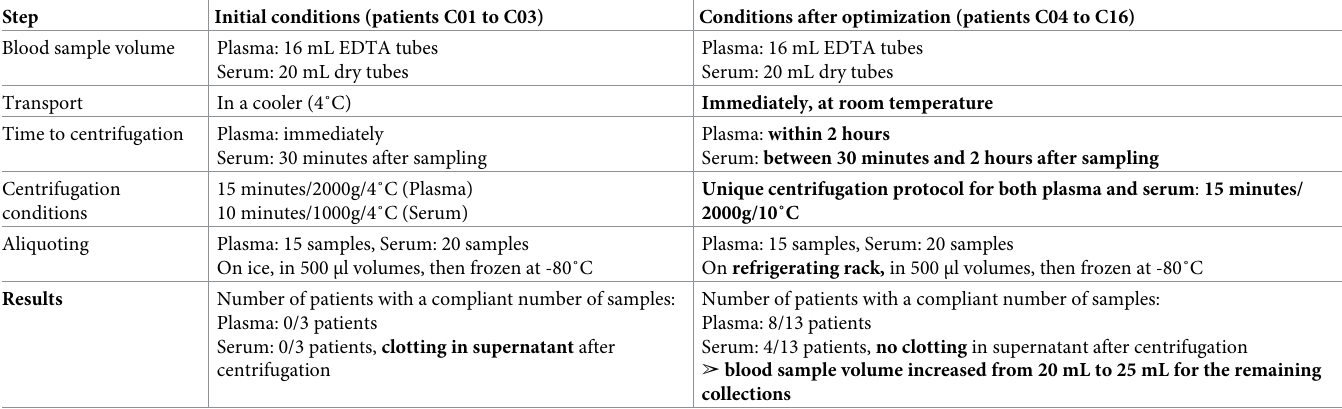
Table 3. Initial and optimized conditions for plasma and serum biospecimen preparation and the corresponding findings.